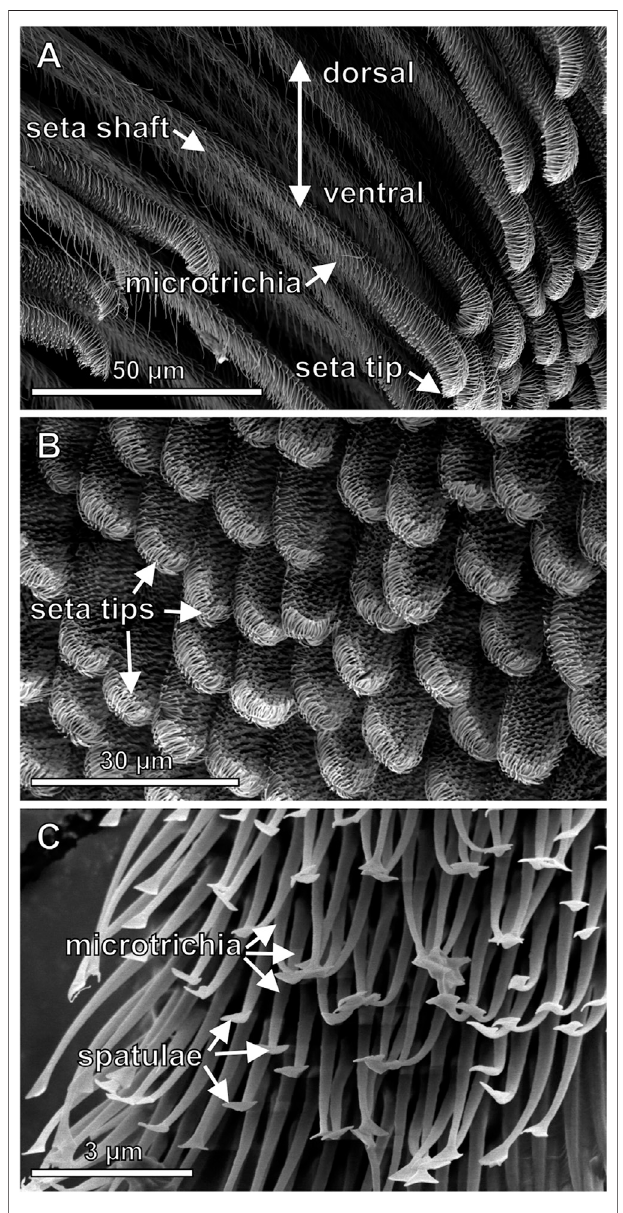
FIGURE 2 | Scanning electron micrographs of the fi ne structures of the adhesive setae (A) Side view of the setae consisting of the up to 1.8 mm long hair shaft (not shown in full length) and the tip region with differently shaped microtrichia. Differences of the shapes of the tips are noticeable (B) Top view of the ventral pretarsal scopula surface. At the end of the setae there are densely arranged spatula-shaped microtrichia contacting a substrate surface during locomotion (C) Higher magni fi cation image of the spatula-shaped microtrichia in the tip region.